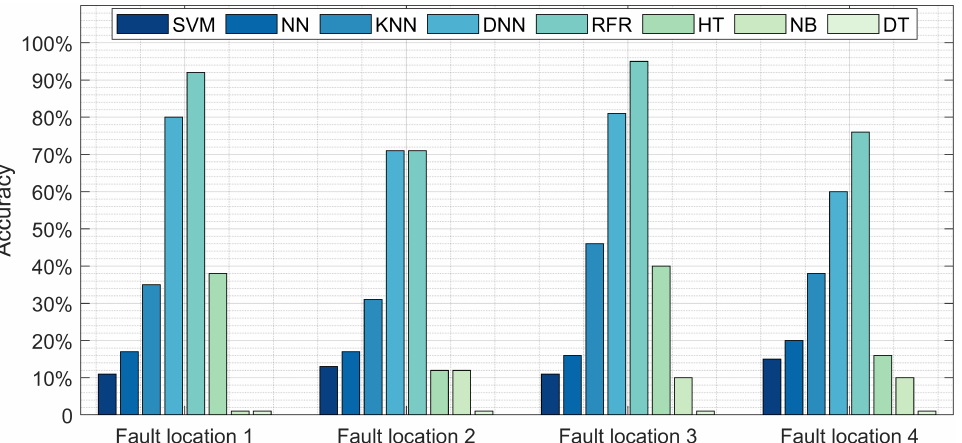
Figure 4. Comparison between the proposed model (RFR) and NN, DNN, SVM, NB, DT, and HT in terms of fault location detection accuracy at various